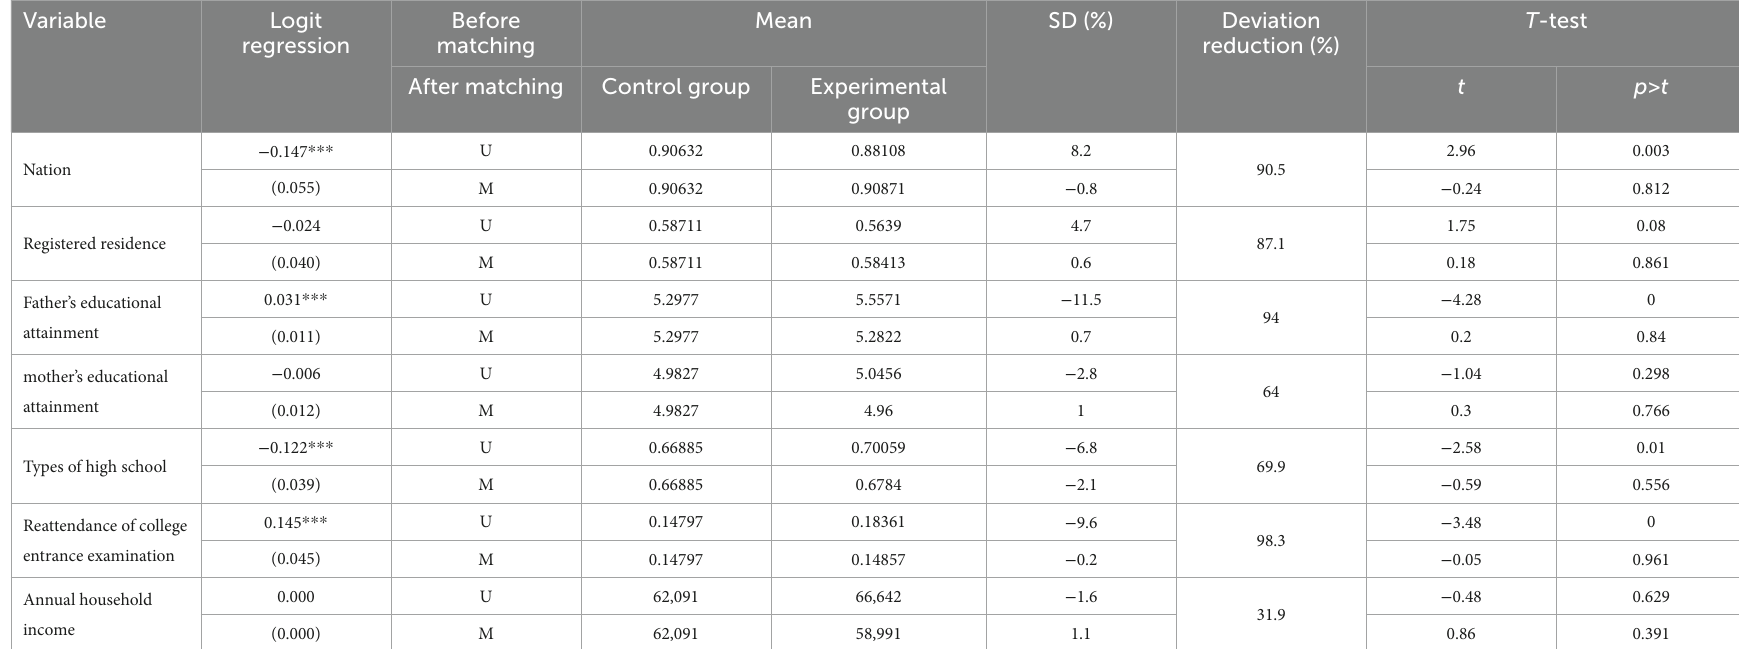
Mean SD (%) Deviation